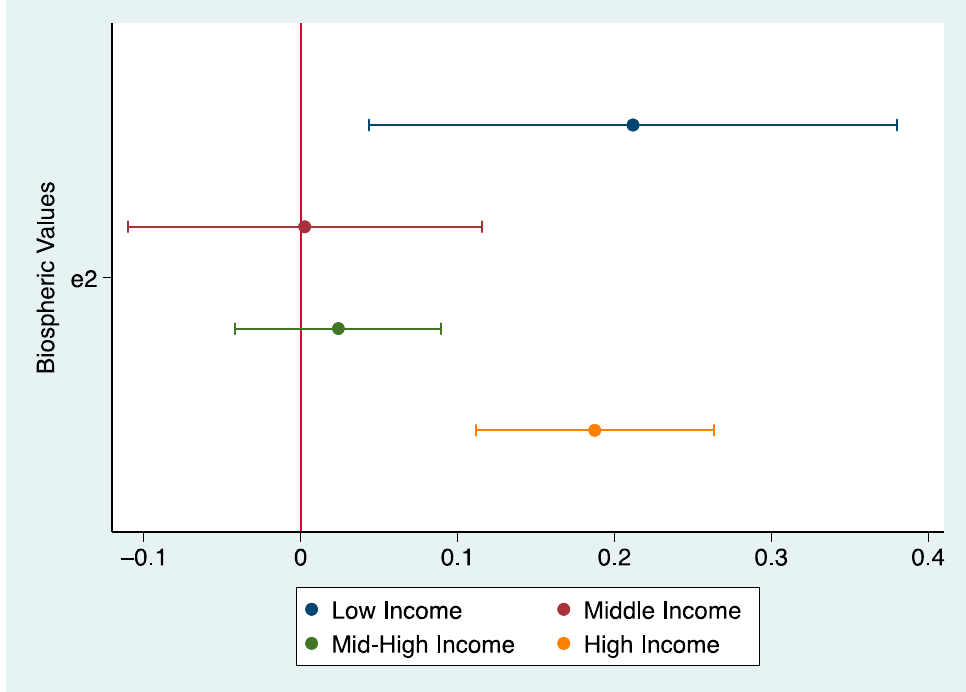
Figure 8. OLS coefficients for biospheric values on attitudes by income, no covariates shown.